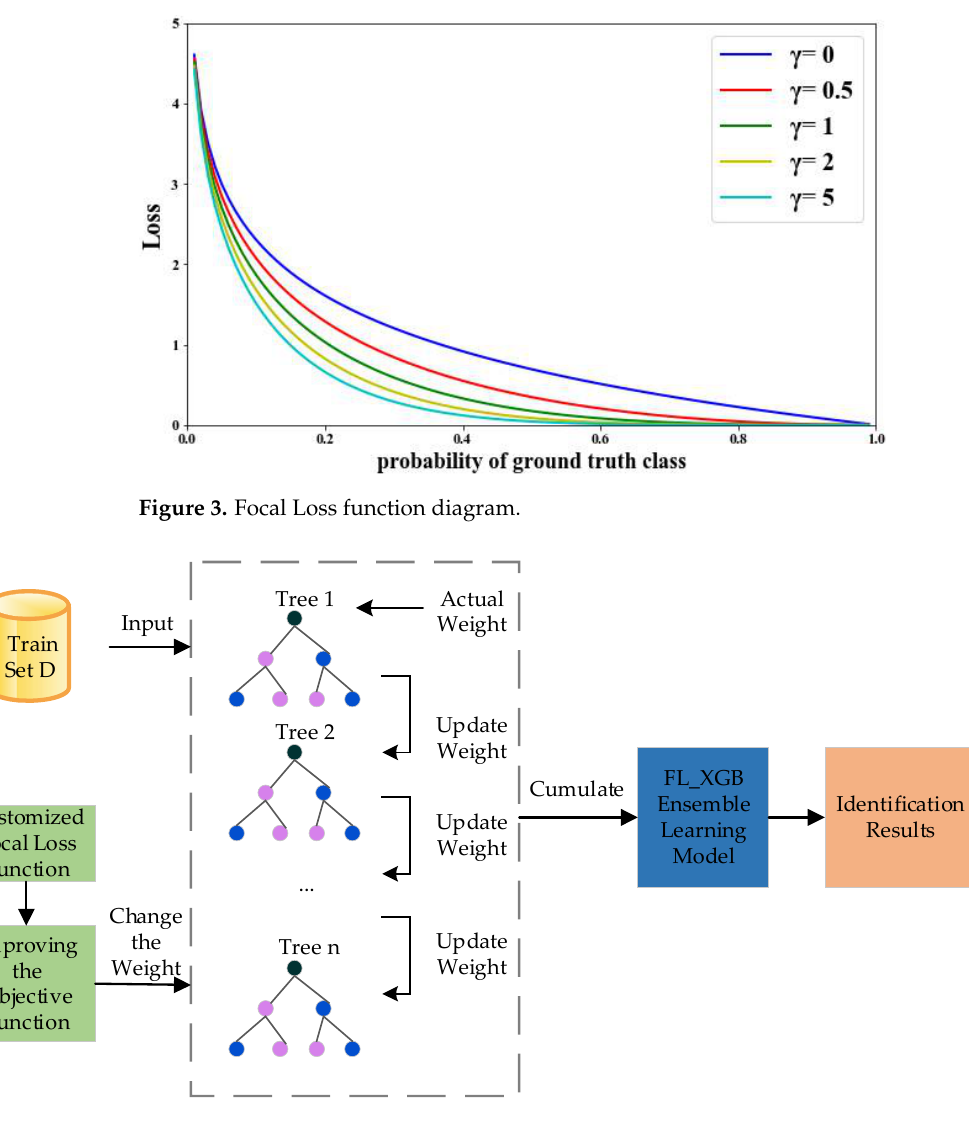
Figure 4. The framework of the FL_XGB model.